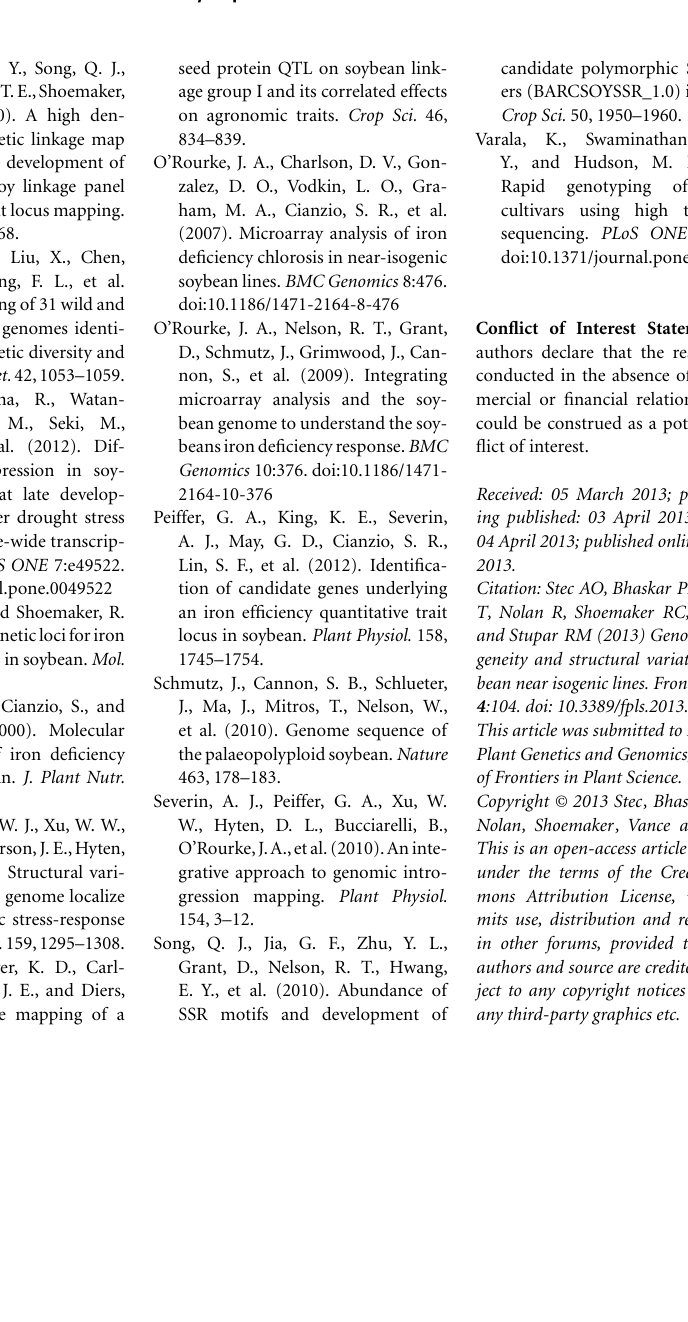
Figure S1 | “T203” introgressions in seven “IsoClark” sub-lines on chromosomes 04, 05, 08, 09, 13, 14, and 16. Figure S2 | Examples of the 1–5 scale used for the visual scoring of IDC in the hydroponic